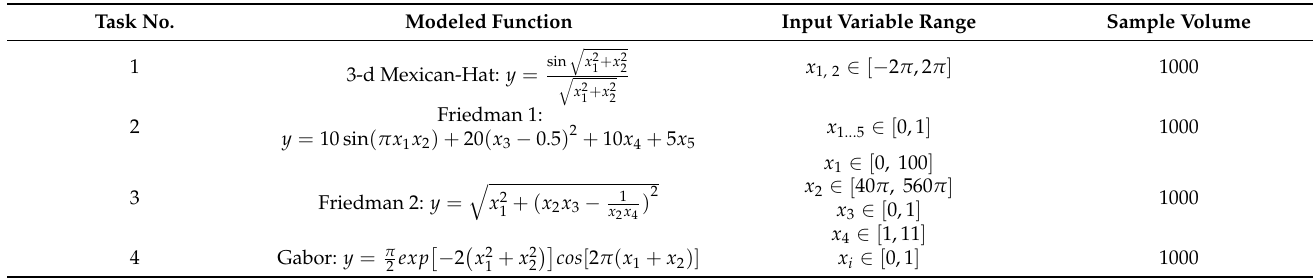
Table 1. Functions and information for generating test